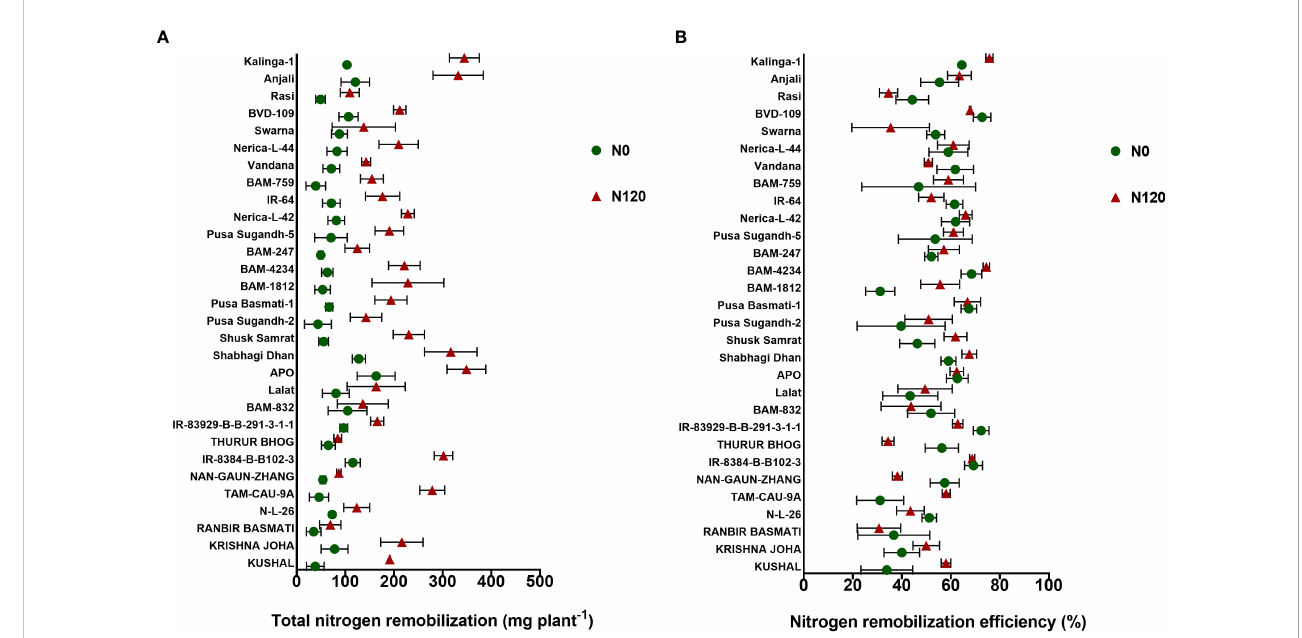
FIGURE 4 Effect of nitrogen de fi cient (0 kg ha-1 fertilizer N: N0) and nitrogen suf fi cient (120 kg ha-1 fertilizer N: N120) fi eld conditions on (A) Total nitrogen remobilization and (B) Nitrogen remobilization ef fi ciency in fi eld-grown diverse rice genotypes during the 2019-kharif season. Values presented are Mean ±SE with three replications.